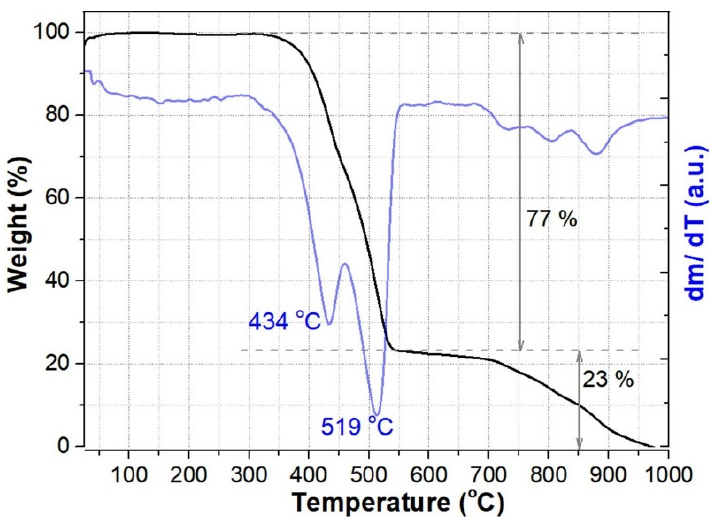
Figure 5. Thermogravimetric analysis of CNWs, at an airflow rate of 60 mL/min at a heating rate of 10 °C min − 1 , shows thermal stability up to 390